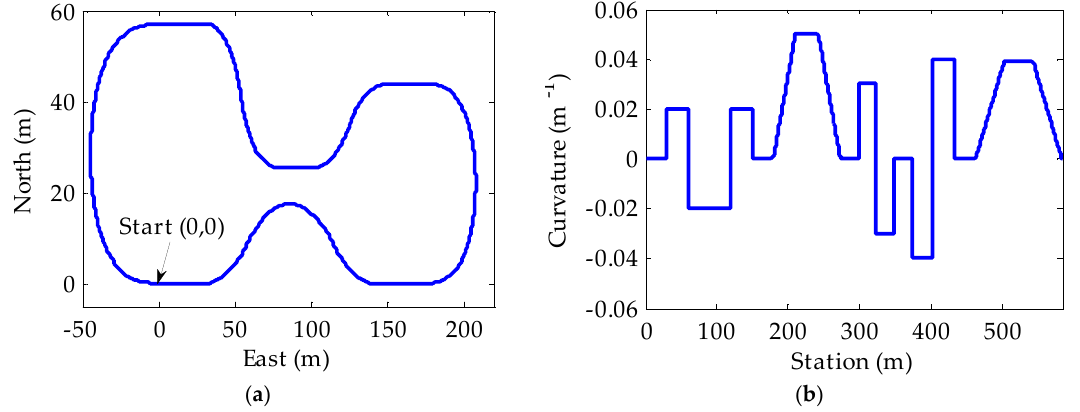
Figure 9. The designed path for steering controller to track. ( a ) Overhead view of path and ( b ) the corresponding curvature varies counterclockwise along the path.